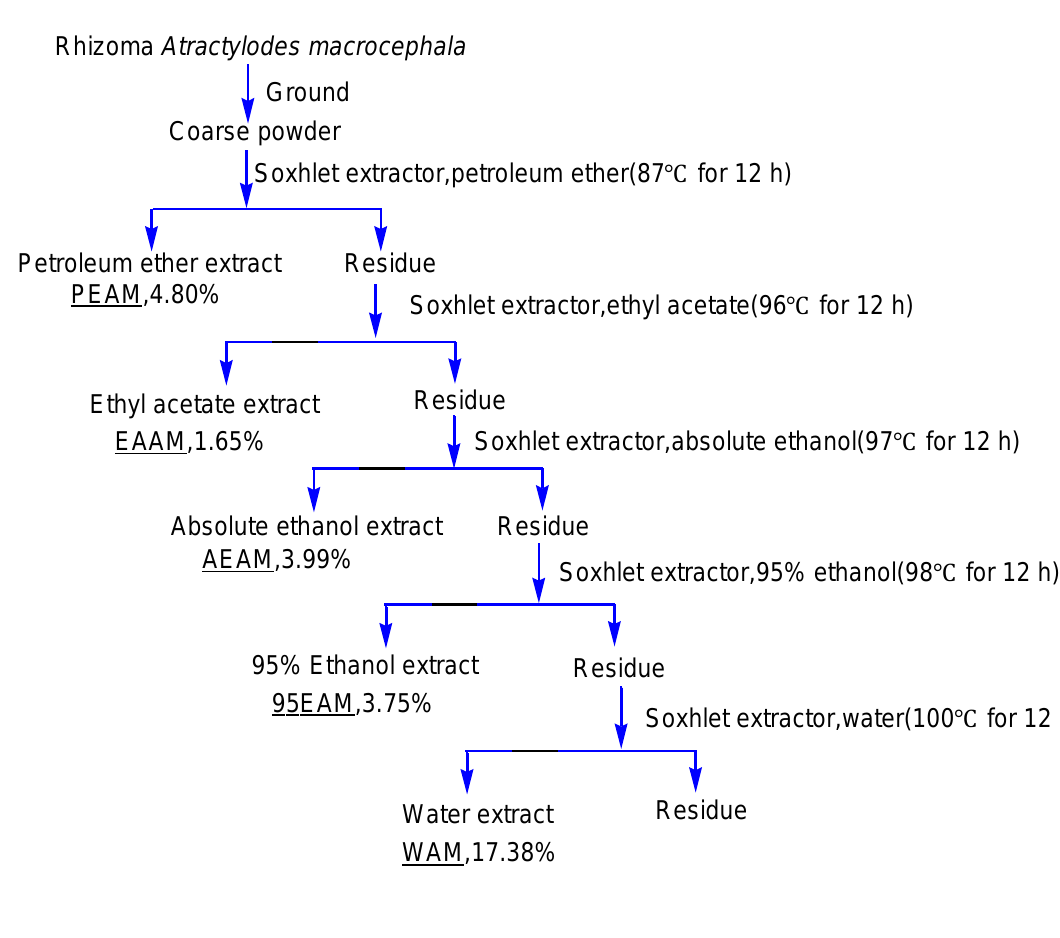
Soxhlet extractor,petroleum ether(87 ℃ for 12